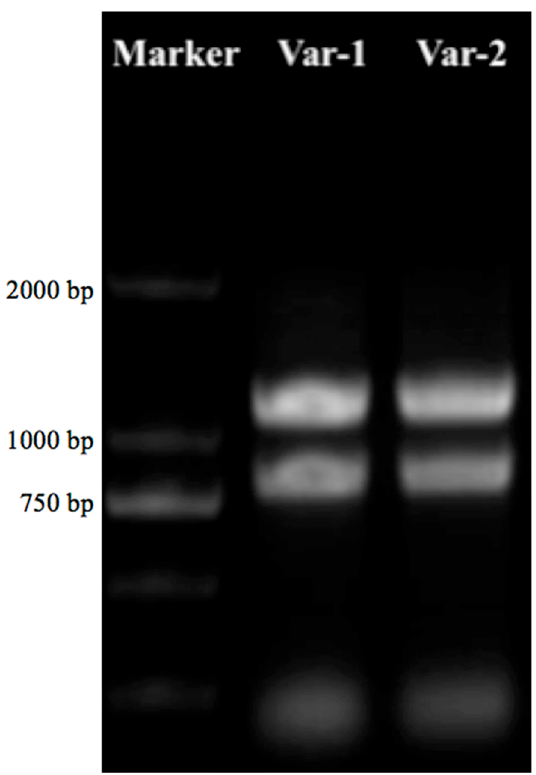
Figure 1. Clear bands of the RNA for alfalfa confirmed by RT-qPCR, where lane 1 represents the marker (DL2000), lane 2 the Var-1 resistance variety (Zhongmu-1), and lane 3 the Var-2 sensitive variety